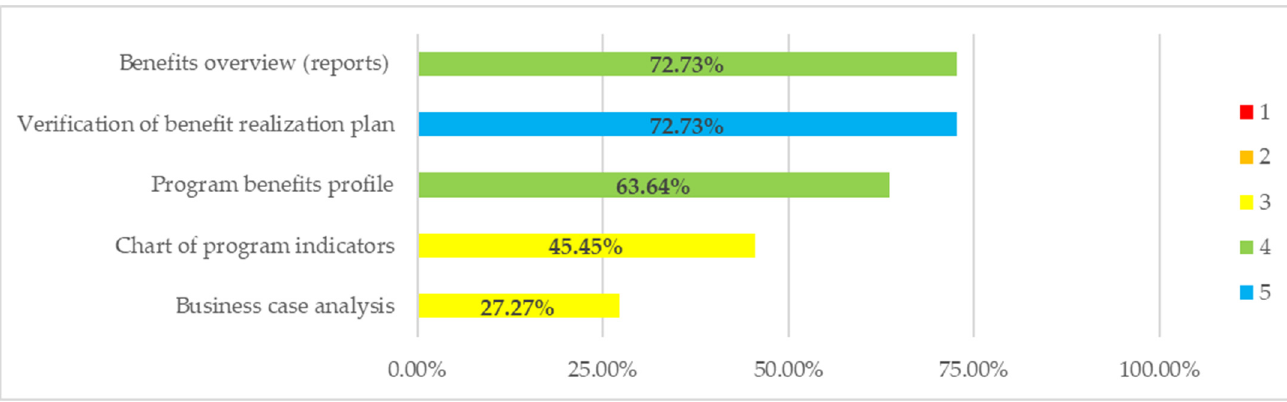
Figure 7. Evaluation of the effectiveness of the methods, techniques and tools used for the benefits provision control process. Source: own elab.